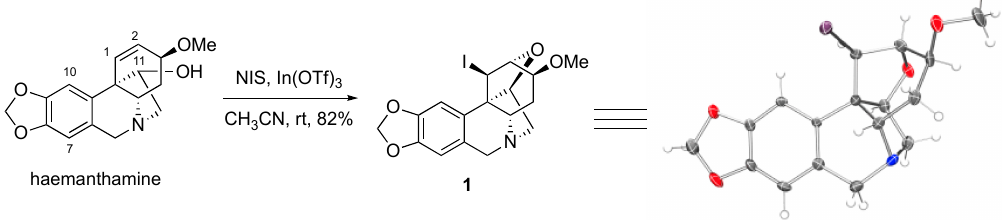
Figure 1. Synthesis of compound 1 and its x-ray structure. Thermal elipsoids are drawn at the 50% probability level.